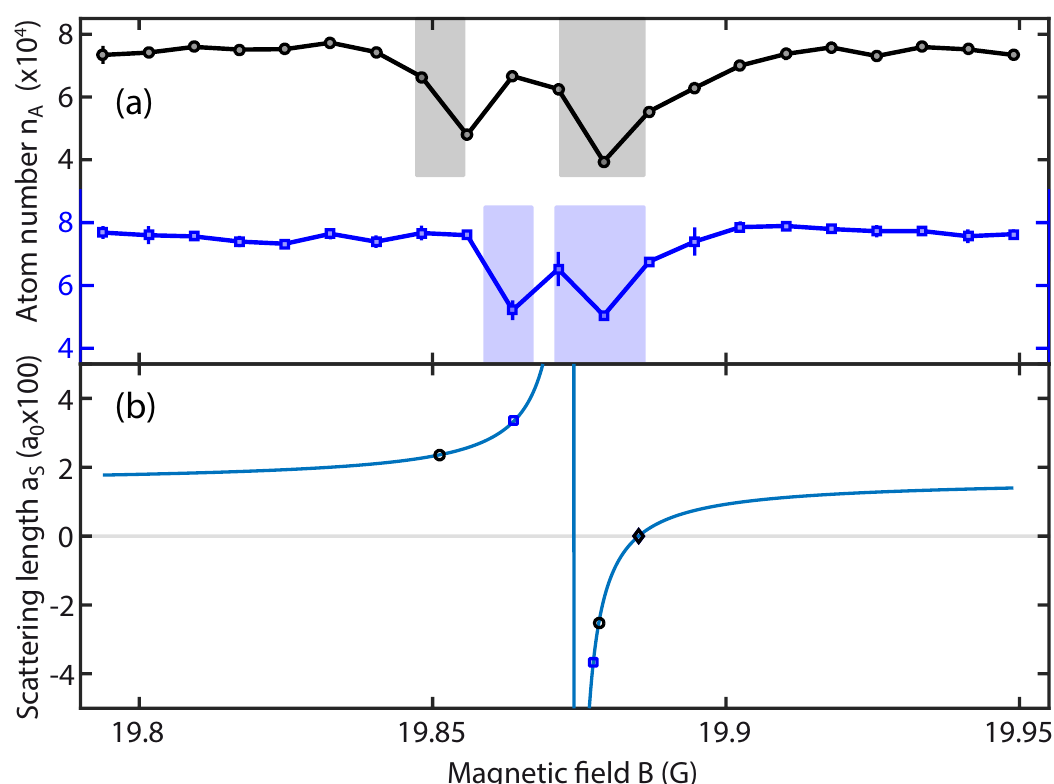
Figure 3: (a) Remaining atom number n for a singly occupied Mott insulator as a A = 500ms and function of B in the vicinity of the Feshbach resonance at 19.9G with t H = 30 E = 50ms and V = 20 E V (top circles) and t (bottom squares). The x , y , z R H x , y , z R shaded areas mark the regions for which | U | = E , incorporating a width of 8mG (see (b)). The solid lines connect the data points are guides to the eye. (b) Calculated scat- = 19.874G and ∆ B = 11mG. tering length around the Feshbach resonance using B 0 The local background scattering length in this range is ≈ 160a . Magnetic field val- 0 = 30 E = 20 E ues where | U | = E for V (circles) and V (squares), and where x , y , z R x , y , z R | U | = 0 (diamond) are